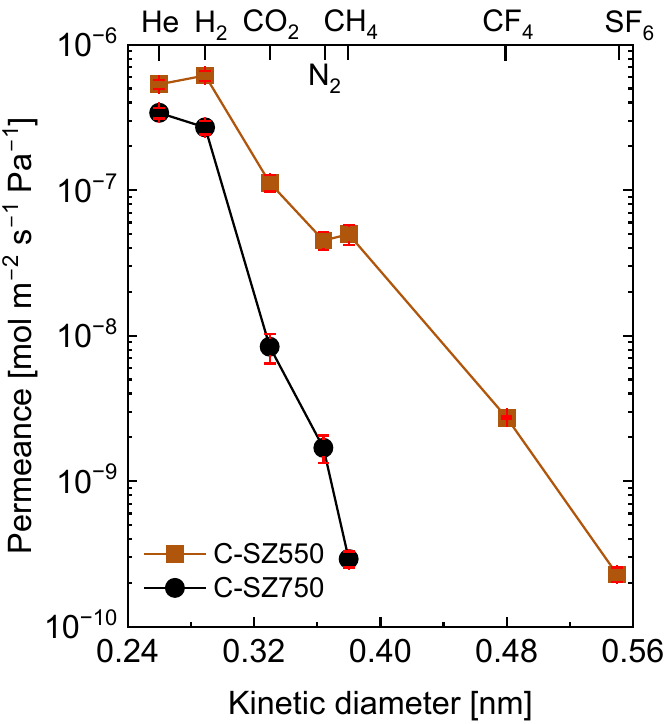
Figure 7. Single-gas permeance at 300 °C as a function of kinetic diameter for carbon-SiO 2 -ZrO 2 membranes prepared at 550 and 750 °C.